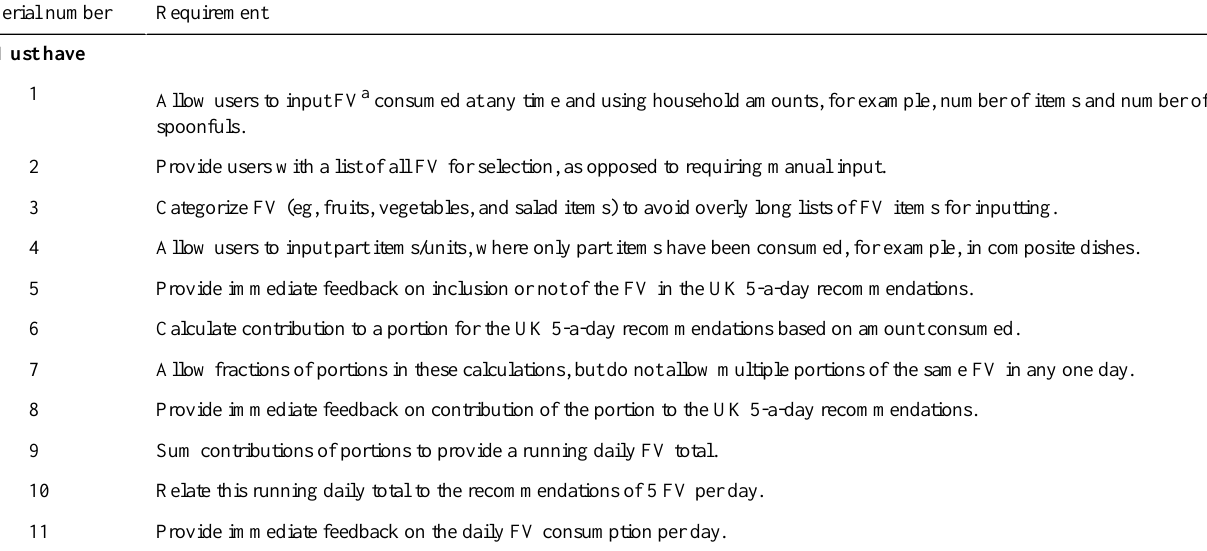
Table 1. Must have, Should have, Could have, Won’t have (MoSCoW) requirements for the app. RequirementSerial